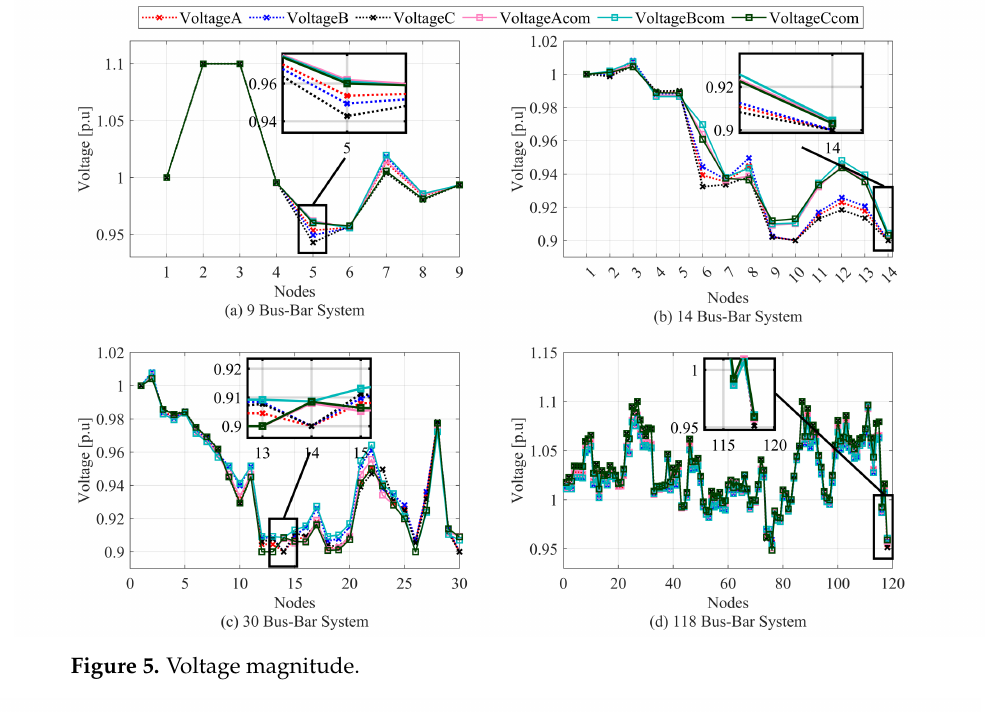
Figure 5. Voltage magnitude.